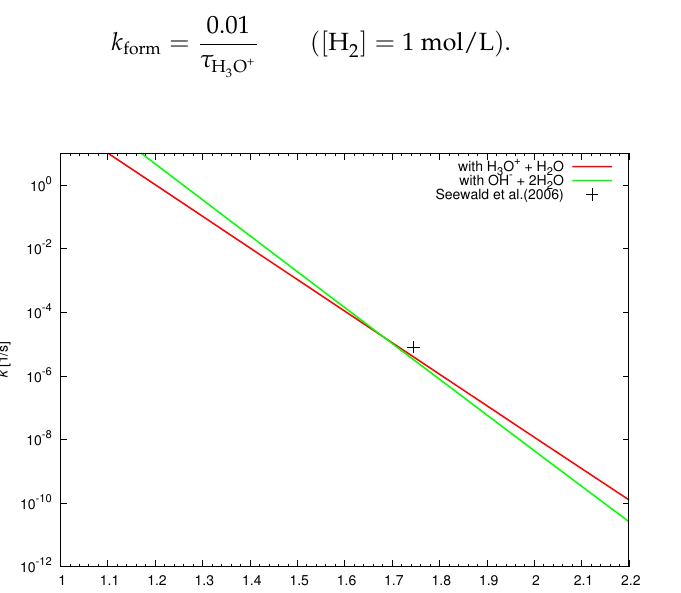
Figure 8. Rate constants for the acid–base catalyzed reductions of methanol calculated in the present study as well as that determined by the laboratory experiment [44]. A hydronium and a water molecule were included in the acid catalyzed reduction, while the reduction was catalyzed by a hydroxyl and two water molecules in the base catalyzed